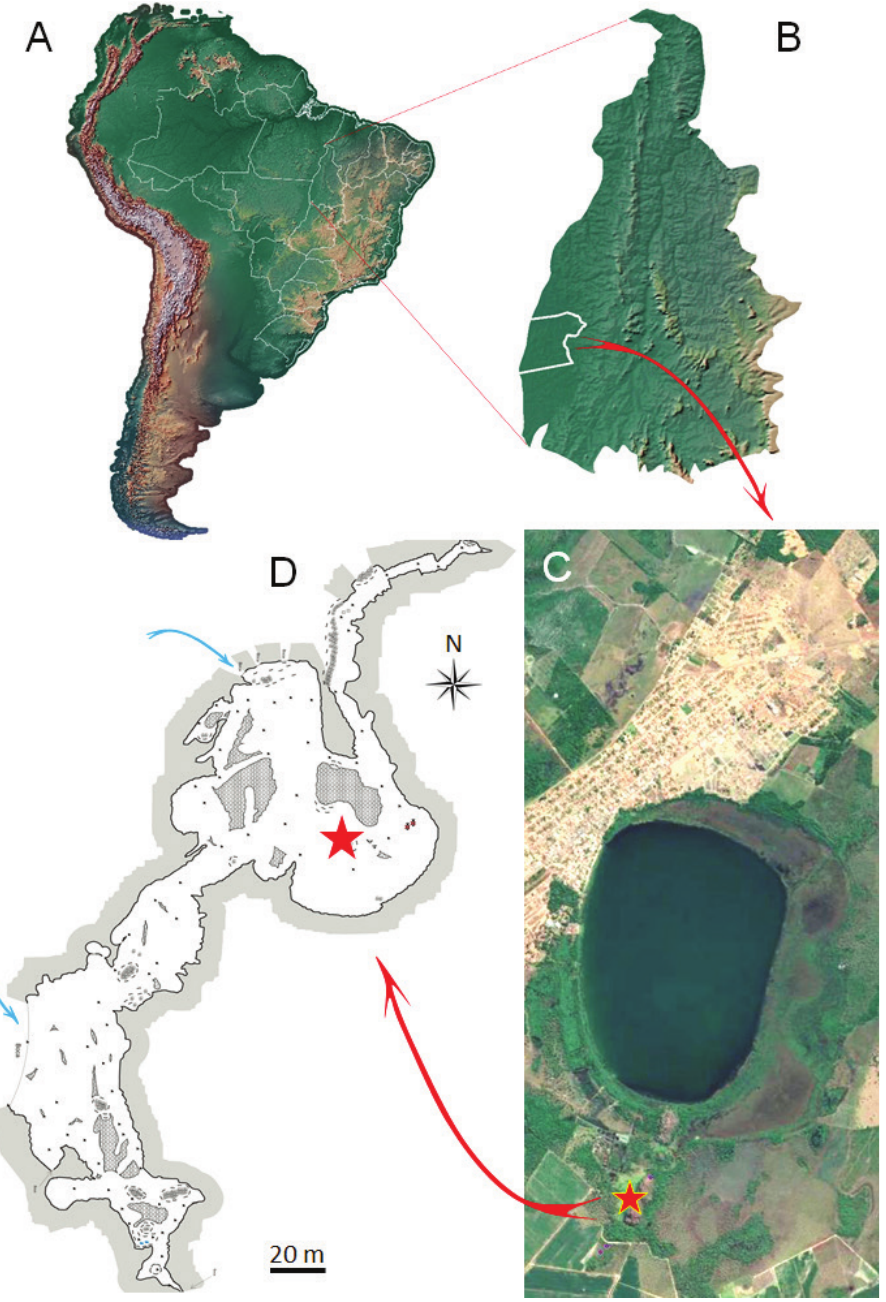
Figure 33. Location of the Casa de Pedra cave A South America, with Brazilian states highlighted B Tocantins state with Lagoa da Confusão municipality highlighted in white lines C aerial view from the Lagoa da Confusão region, where the urban area and the karst lake are visible; red star indicating the location of the Casa de Pedra cave D Casa de Pedra cave; red star indicating the location of Eupera troglobia sp.